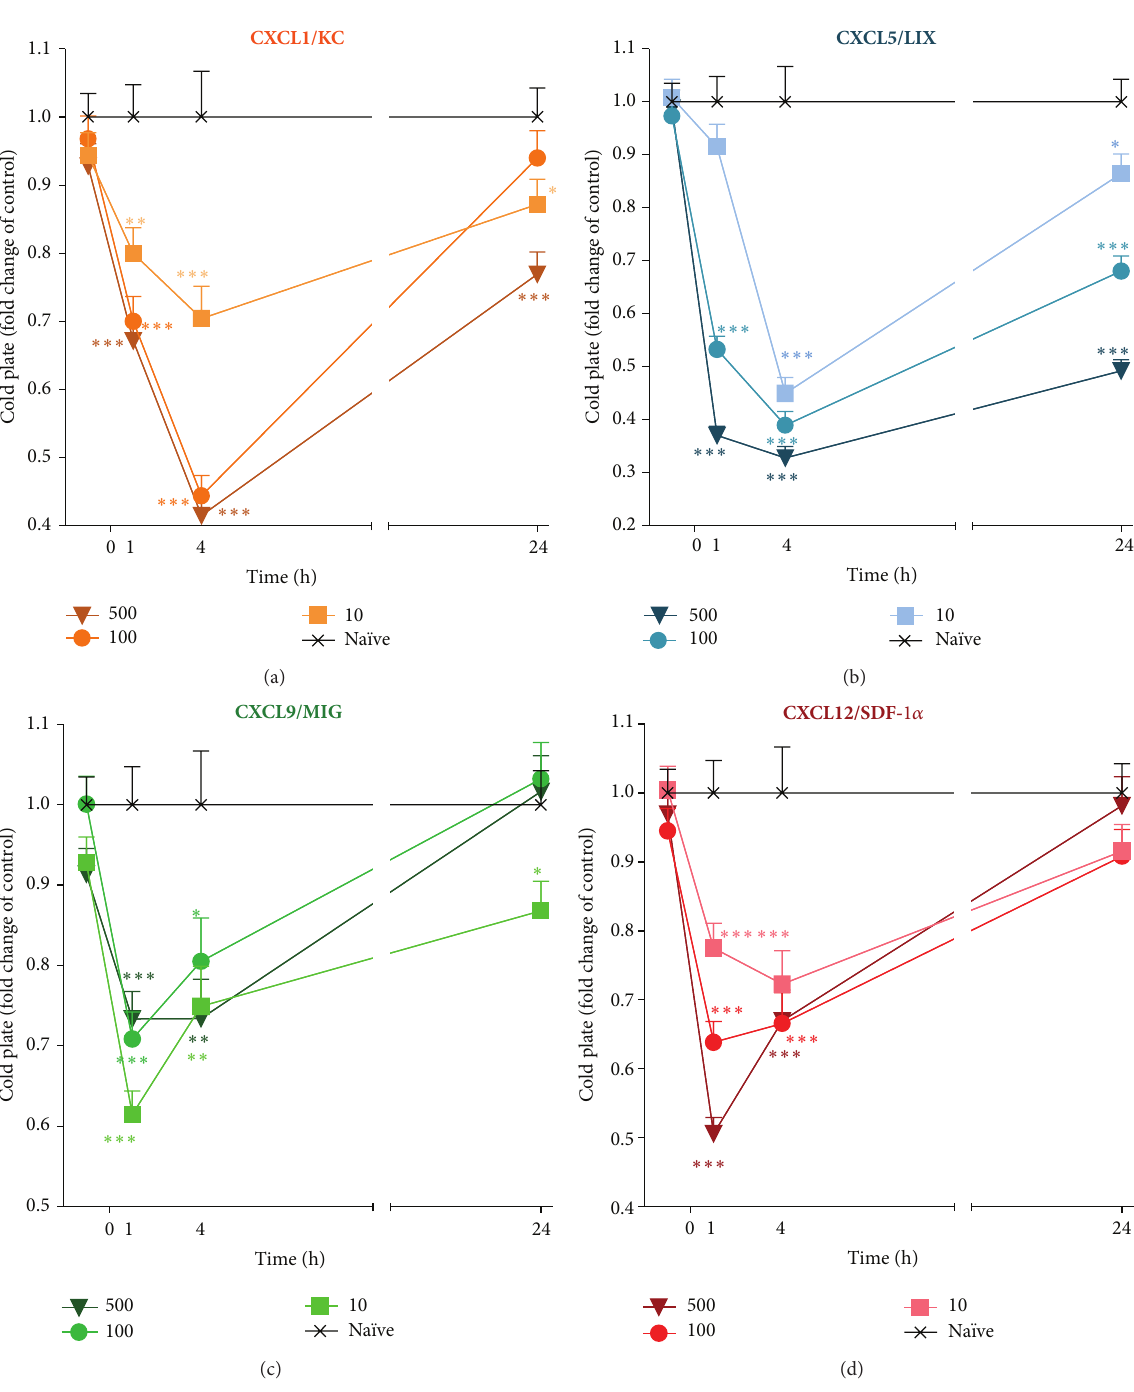
Figure 6: Effects of CXCL1, CXCL5, CXCL9, or CXCL12 administration on thermal hyperalgesia. The influence of a single intrathecal administration of 10ng, 100 ng, or 500ng/5 𝜇 L of CXCL1 (a), CXCL5 (b), CXCL9 (c), or CXCL12 (d) on thermal hyperalgesia was evaluated using the cold plate test. The measurements were taken 1, 4, and 24 hours after chemokine administration. The data are presented as fold change in the control (na¨ıve) ± S.E.M. (6–16 mice per group). Intergroup differences were analyzed by an ANOVA and Bonferroni’s Multiple Comparison Test. ∗ 𝑃 < 0.05 , ∗∗ 𝑃 < 0.01 , and ∗∗∗ 𝑃 < 0.001 indicate a significant difference; the statistical analysis was performed versus control (na¨ıve)